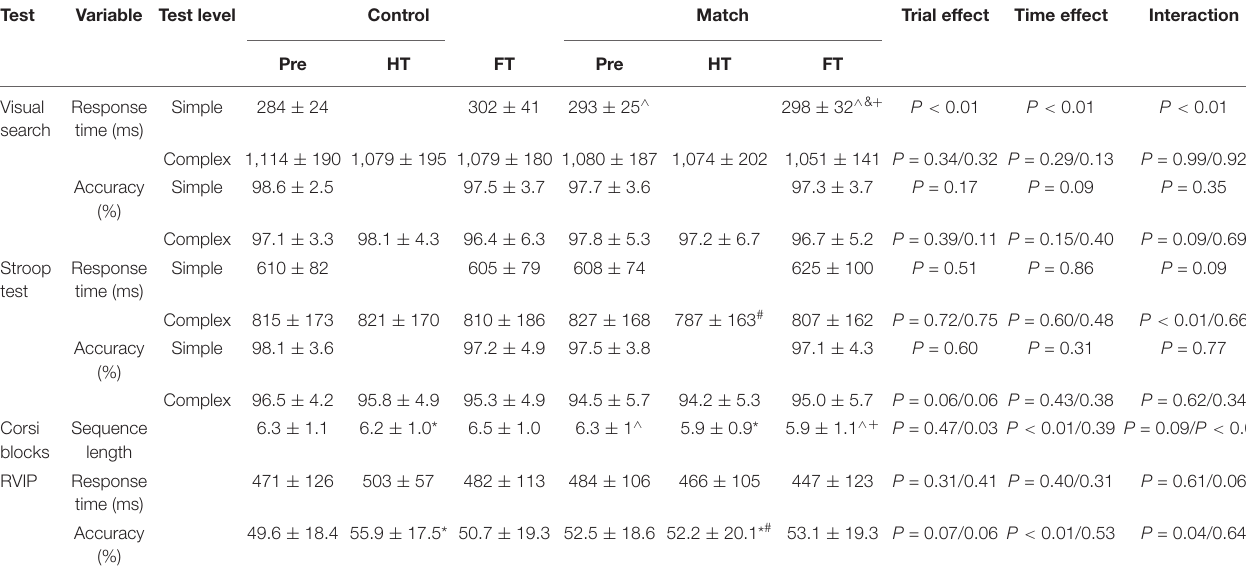
TABLE 1 | Cognitive function data across the control and match day